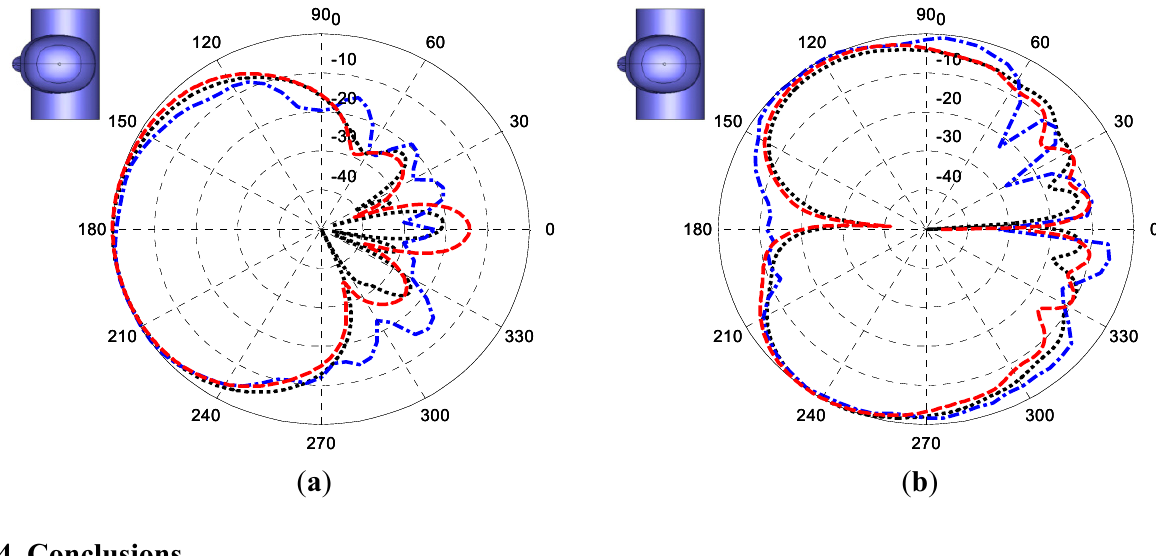
Figure 9. The H-plane cut radiation pattern of the AUT measured at 2.5 GHz: ( a ) co-polar field component; and ( b ) cross-polar field